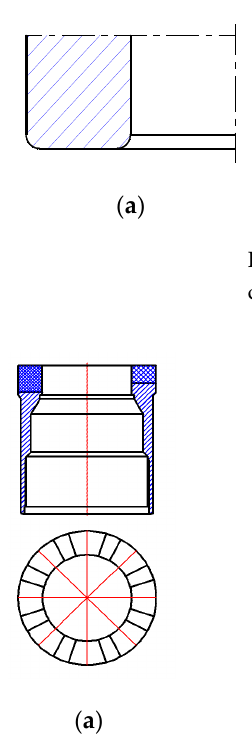
Table 4. Statistics on bit ‐ drilling efficiency of diamond core bit in Pingdu Hole 28ZK5.